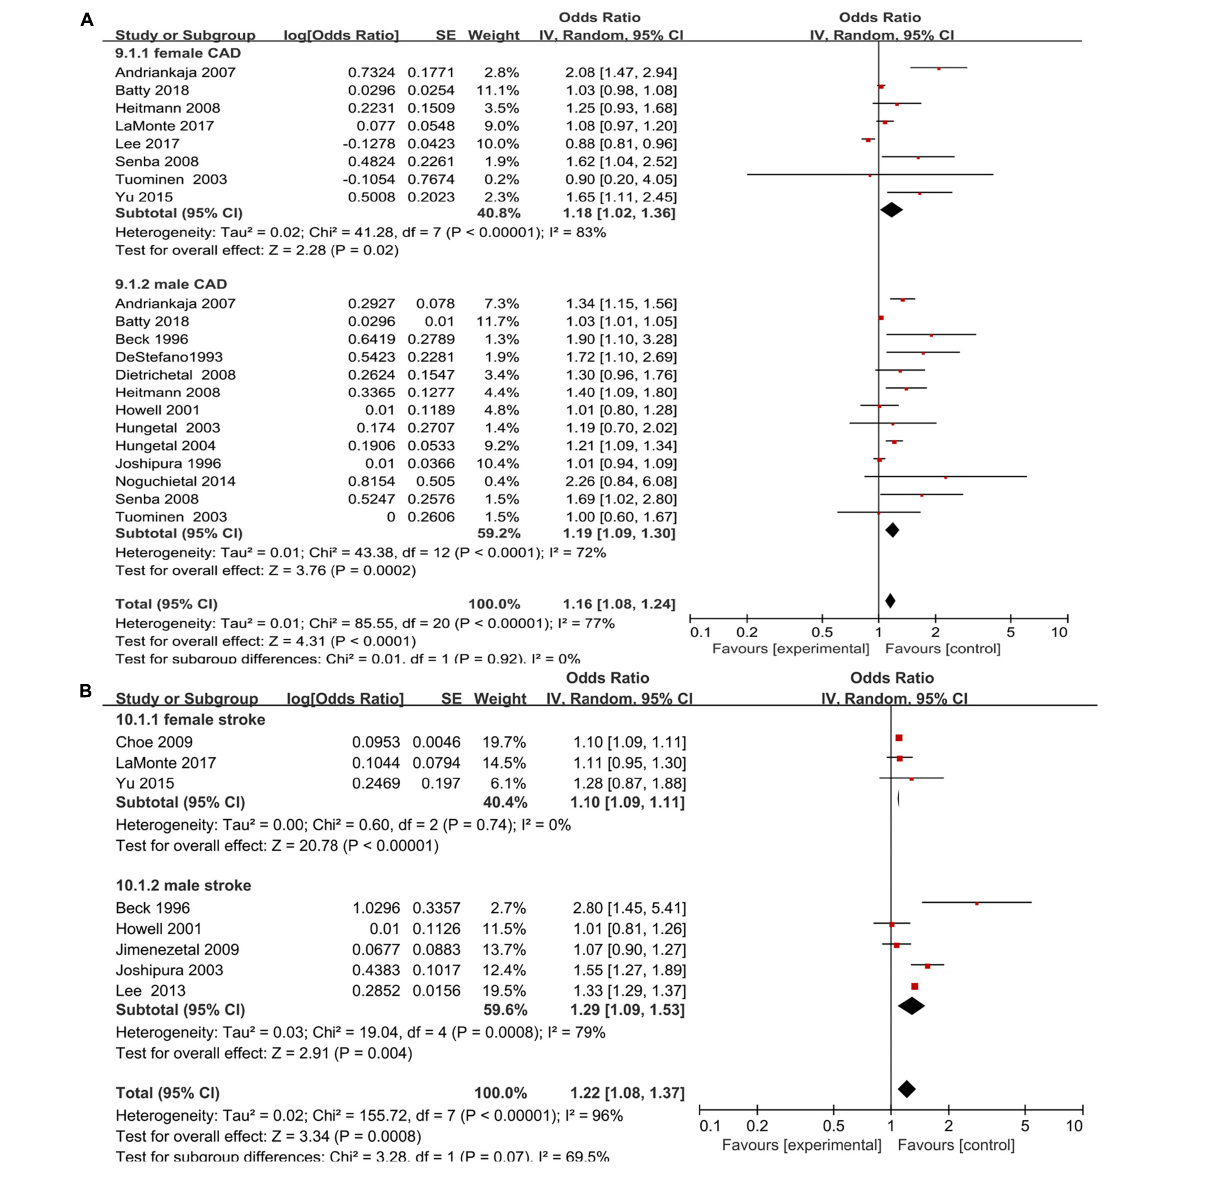
FIGURE5 Forest plot of the risk of coronary artery disease and stroke in periodontal disease patients by sex [ (A) Coronary artery disease and (B) stroke]. In the forest plot, the diamond indicates the pooled estimate. Red boxes are relative to study size and the black vertical lines indicate 95% CIs around the effect size